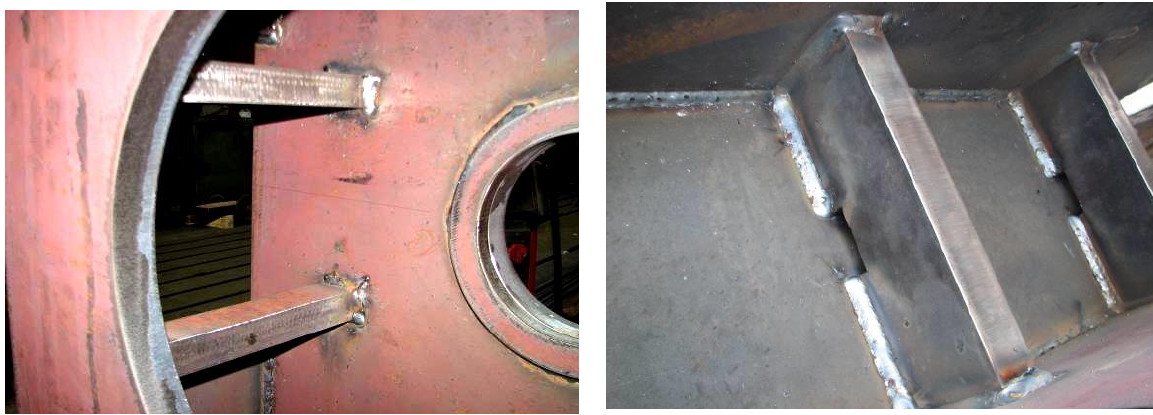
Figure 18. New adder box with reinforcements.